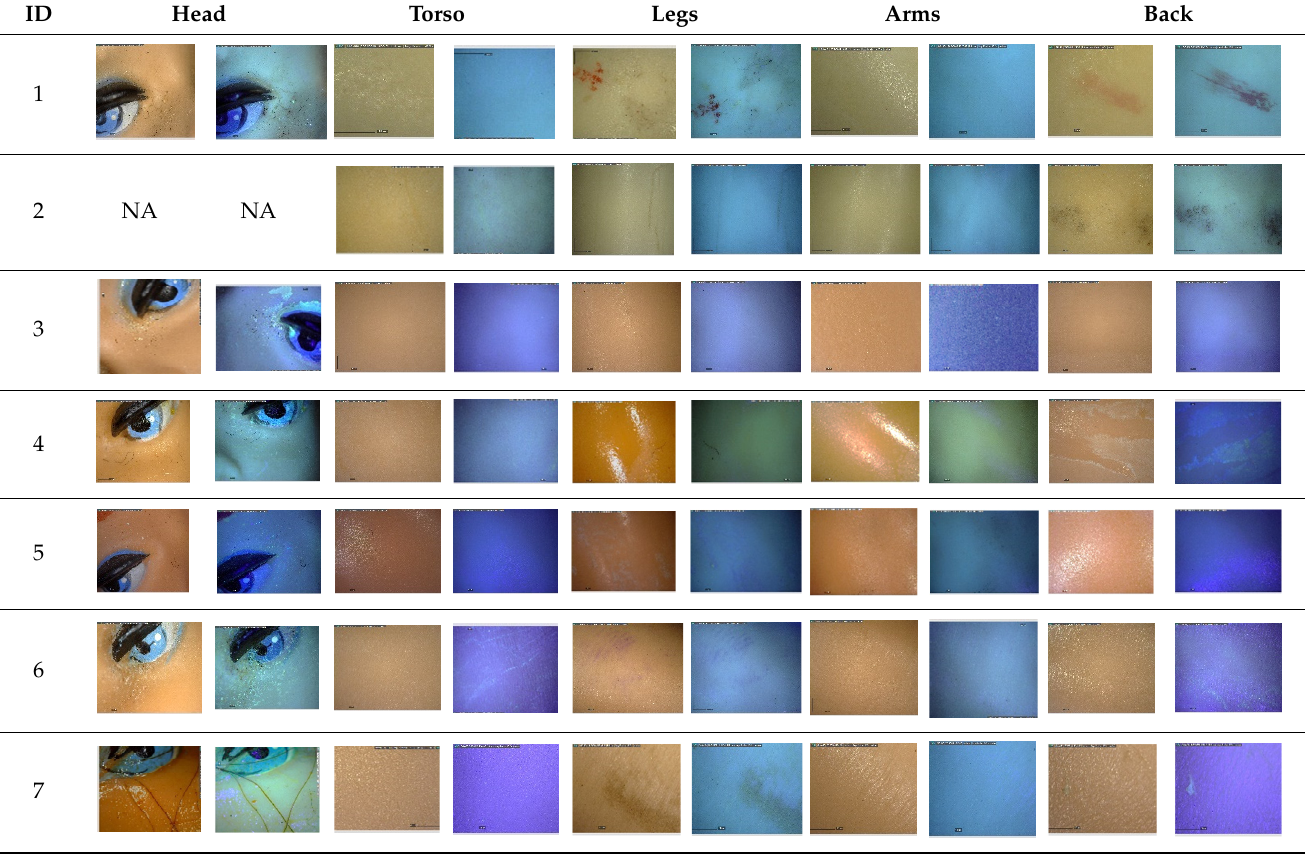
Table 3. Microscopic images (magnification: 50×) under VIS and UV light: details of the head, torso, legs, arms, and back on each Barbie identified through the ID number.